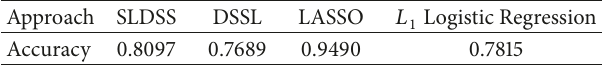
Table 2: Performance on H3N2 influenza gene expression dataset as measured by the fraction of correctly ordered pairs